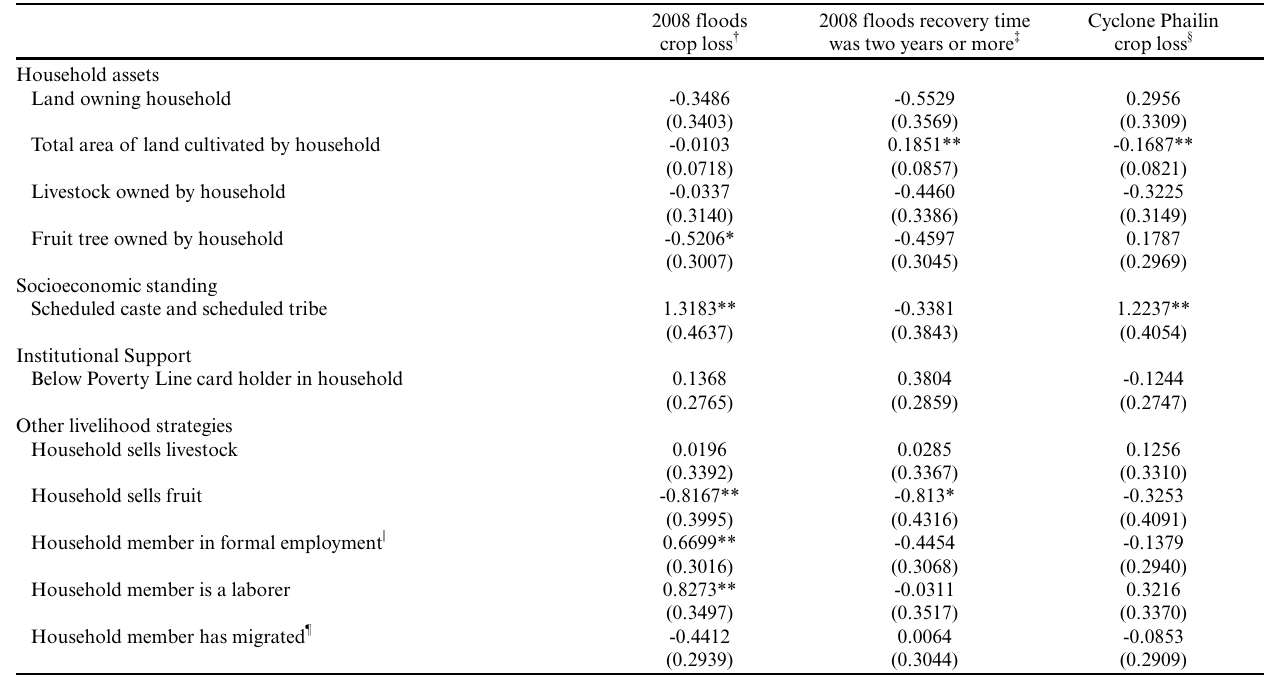
Table 4 . The effect (coefficient) of household asset levels, socioeconomic standing, access to institutional support, and partaking in other livelihood strategies on a household’s probability of suffering greater crop loss following the 2008 floods or cyclone Phailin and the probability to take longer to recover pre-2008 flood rice cropping